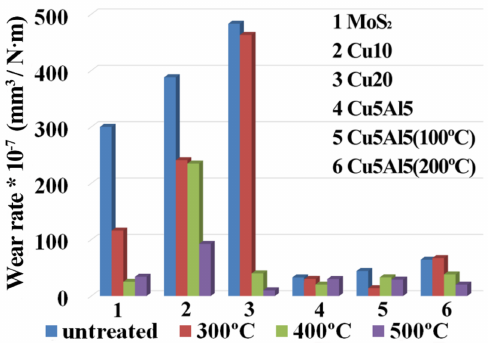
Figure 12. Wear rate of MoS 2 -based coatings at various heat treatment